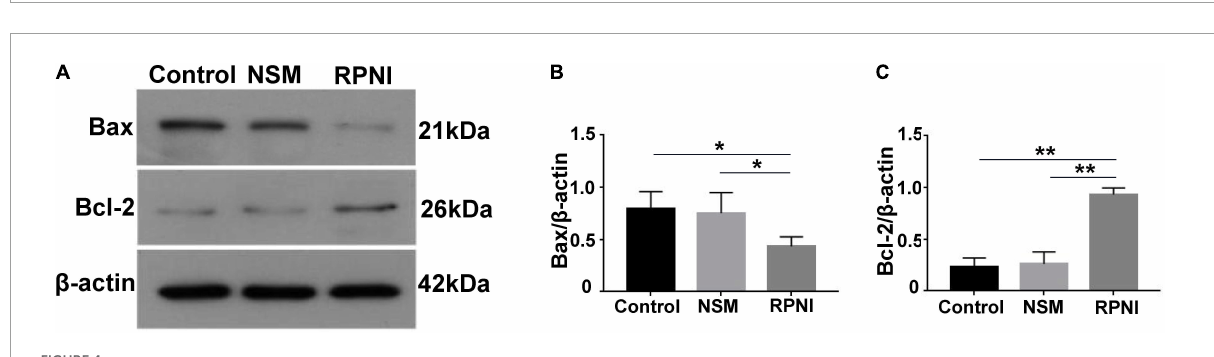
FIGURE4 Western blot results of apoptosis-related proteins in ipsilateral DRG. (A) Western blotting bands of Bax and Bcl-2 expressions from pooled ipsilateral L4 and L5 DRGs harvested at 8 weeks after surgery. (B,C) The quantifications of corresponding western blot signals in panel (A) . (* p < 0.05, ** p < 0.01). DRG, dorsal root ganglia; NSM, nerve stump implantation inside the muscle; RPNI, regenerative peripheral nerve